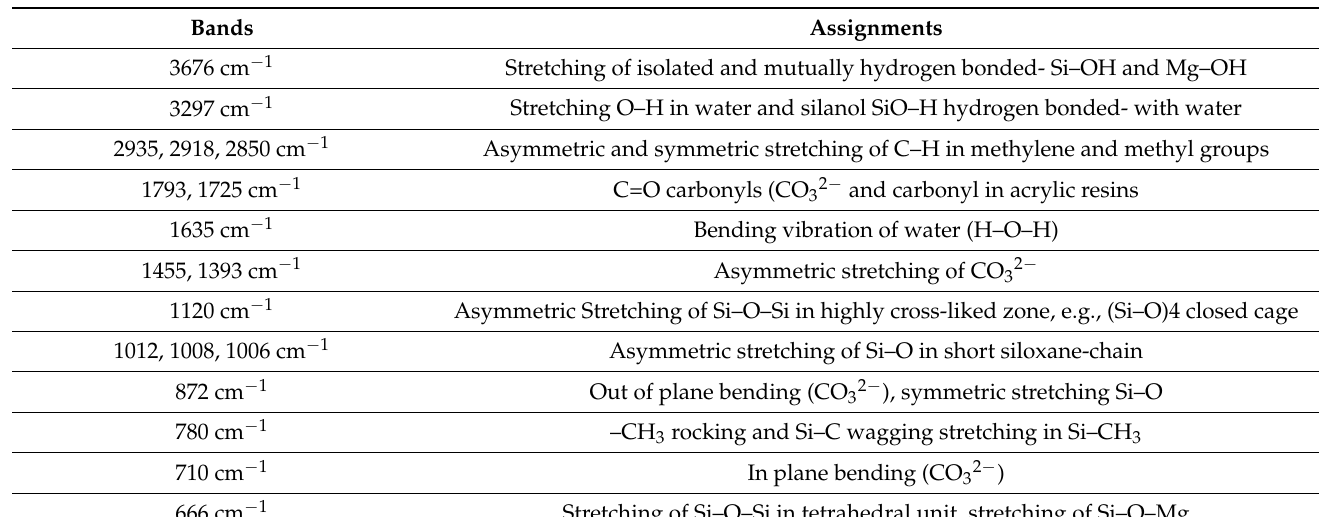
Table 3. FTIR spectra vibration bands assignments